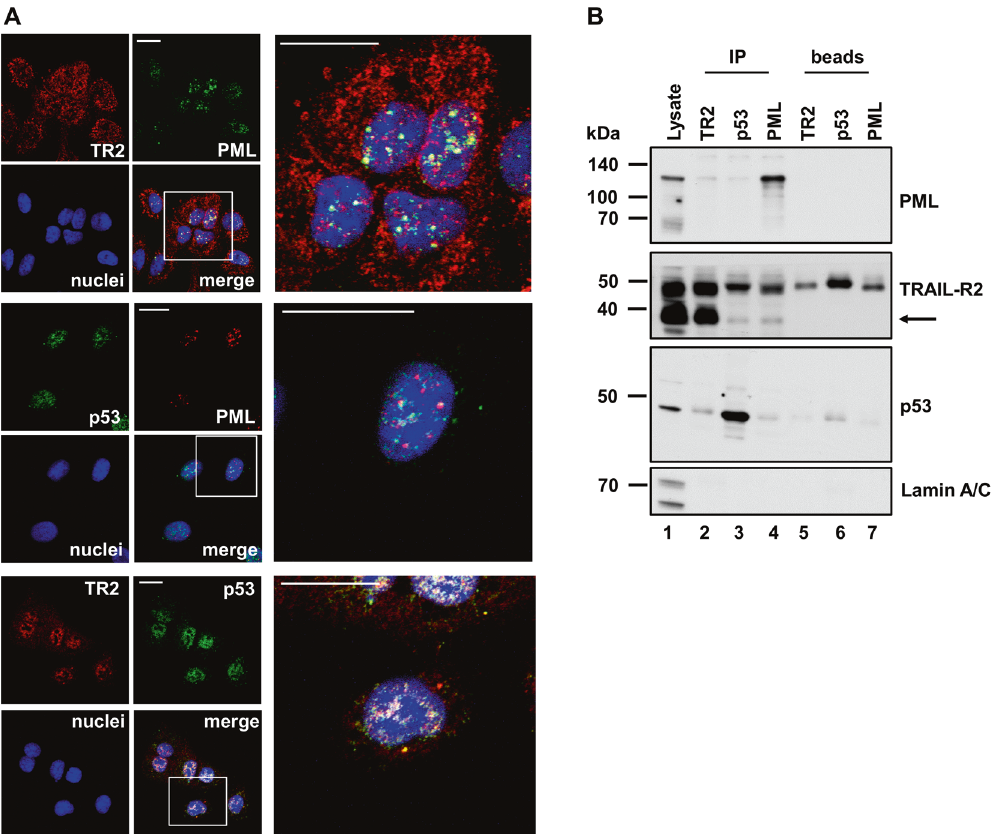
Fig. 6 TRAIL-R2 co-localizes and co-precipitates with PML. A Intracellular localization of TRAIL-R2 (Lexatumumab) and PML(PG-M3), p53 (FL393) and PML (PG-M3) or TRAIL-R2 (HS201) and p53 (FL393) was analyzed by indirect immuno fl uorescence followed by confocal LSM in A549 WT cells. Scale bar 20 µm. B TRAIL-R2, p53 and PML were precipitated from nuclear fractions of A549 WT cells by speci fi c antibodies [anti-TRAIL-R2 antibody (HS201), lane 2; anti-p53 antibody (DO-1), lane 3 and anti-PML antibody (PG-M3), lane 4]. As controls, beads with antibodies were analyzed in parallel (lane 5, 6, and 7). Nuclear lysates and precipitated protein complexes were examined by western blotting [anti-TRAIL-R2 antibody (2019); anti-p53 antibody (FL393) and anti-PML antibody (33156). Lamin A/C was analyzed in parallel as a marker for the nuclear